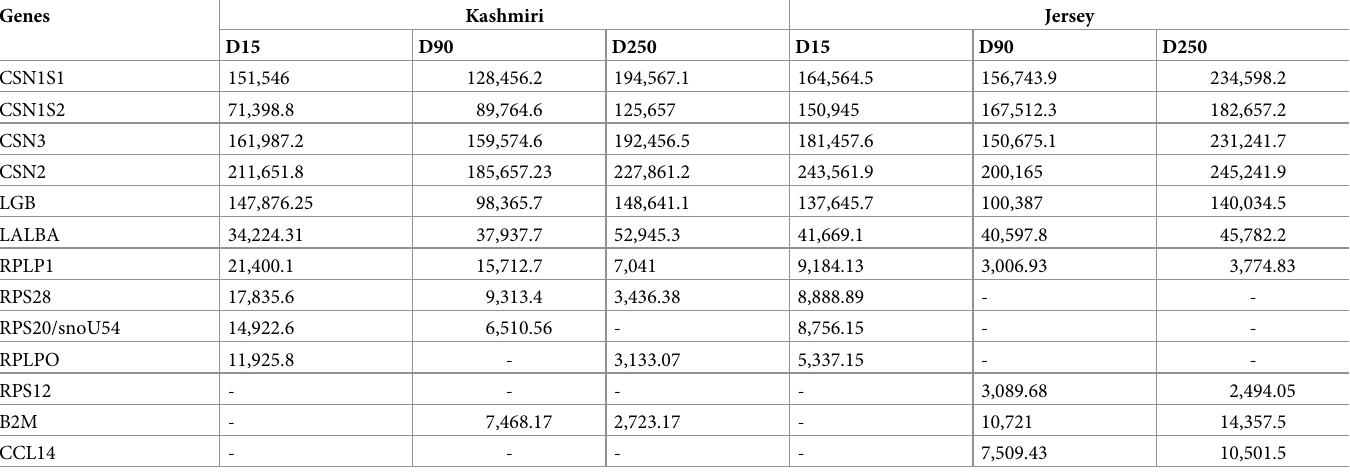
Table 2. Highly expressed genes in mammary epithelial cells with FPKM values > 2000 at three different stages of lactation in Kashmiri and Jersey cattle 1 .